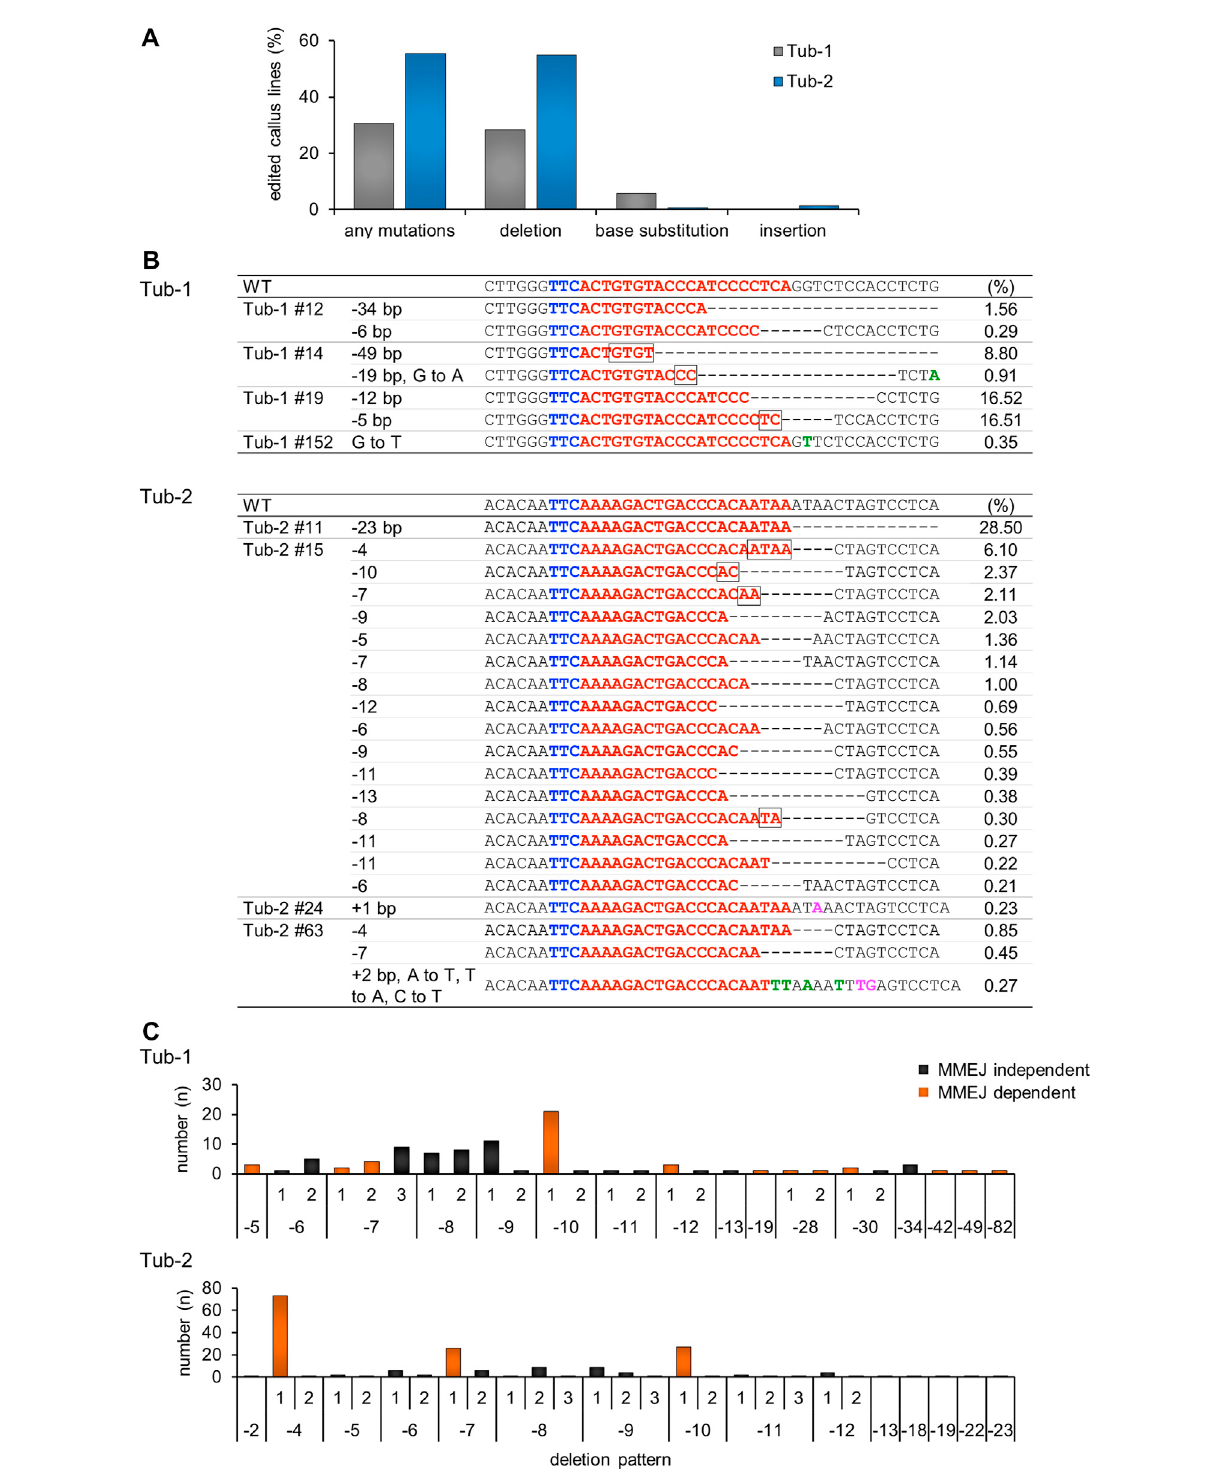
FIGURE 3 Amplicon sequence analysis in SpCas12f-transformed calli. (A) The percentage of transgenic callus lines in which mutations were introduction per total number of callus lines analyzed by amplicon sequencing is shown. The numbers represent the sum of calli analyzed in three replicate experiments. Individual mutation patterns are classi fi ed into deletion, base substitution, and base insertion, and the ratio of each mutation pattern is also shown. (B) ExamplesofampliconsequenceresultsonTub-1(upperpanel)andTub-2(lowerpanel)intransformedcalli.DetailsarethesameasinFigure2Band green or magenta letters on the sequence indicate base substitution or base insertion, respectively. The number shown to the right of each sequence is the frequency, i.e., the ratio of the number of amplicon sequence reads. (C) Histogram showing the correlation between the deletion pattern and the number of samples on Tub-1 (upper panel), and Tub-2 (lower panel). The horizontal axis shows the deletion pattern shown in Supplementary Table S3, and the vertical axis shows the number of samples for which the deletion pattern was detected. The numbers are the sum of calli analyzed in three replicate experiments. Black bars, MMEJ independent deletion pattern; orange bars, deletions caused by